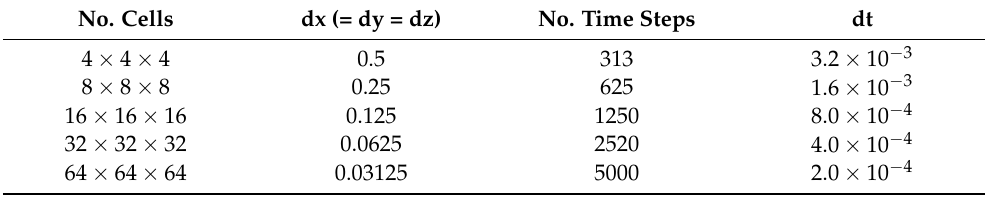
Table 2. Cases to be simulated in the order of accuracy verification of the 3D solver (r x = r t = 2). No.